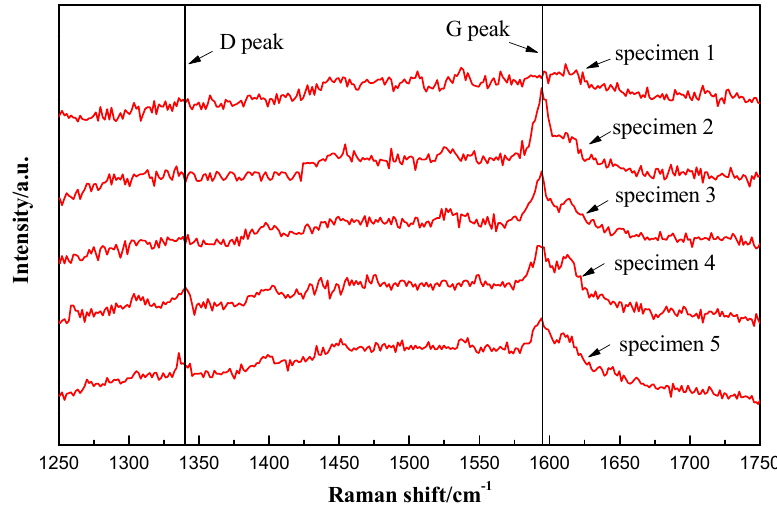
Figure 3. Raman spectrum of different specimens.